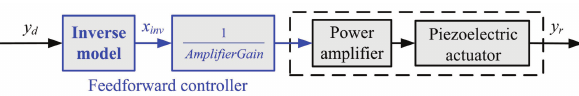
Figure 6. Block diagram of feedforward